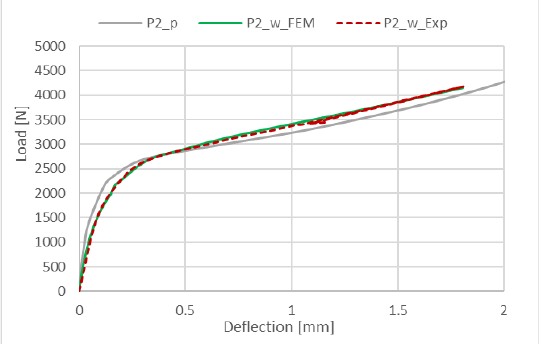
Figure 13. Postbuckling equilibrium paths for perforated profiles with P2 lay-up and for unperforated profiles with P2 lay-up (results from numerical and experimental analysis).